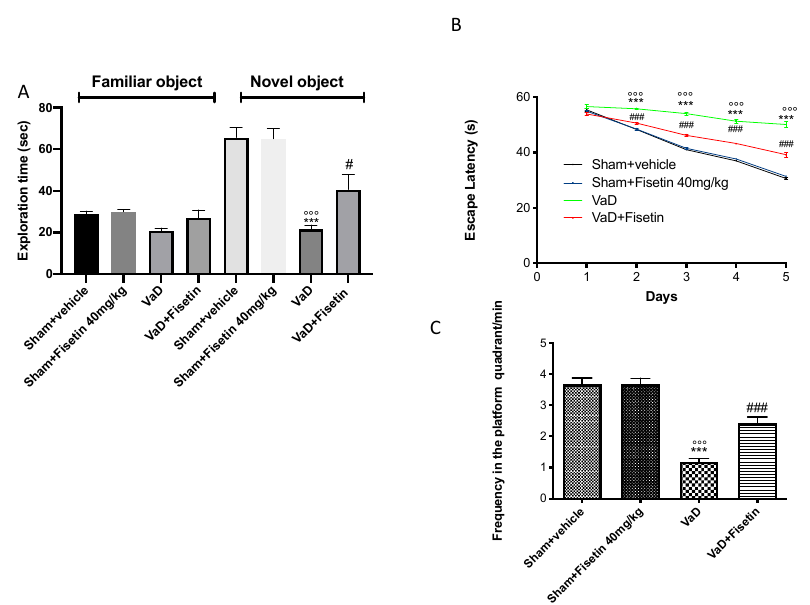
Figure 2. Fisetin administration on behavioral alterations after VaD induction. NOR and MWM tests were evaluated. ( A ) Exploration time in s; ( B ) escape latency; ( C ) frequency in the platform quadrant/min. Values = means ± SEM of 6 animals for each group; *** p < 0.001 vs. sham + vehicle, °°° p < 0.001 vs. sham + Fisetin 40 mg/kg. # p < 0.05 vs. VaD. ### p < 0.001 vs. VaD.